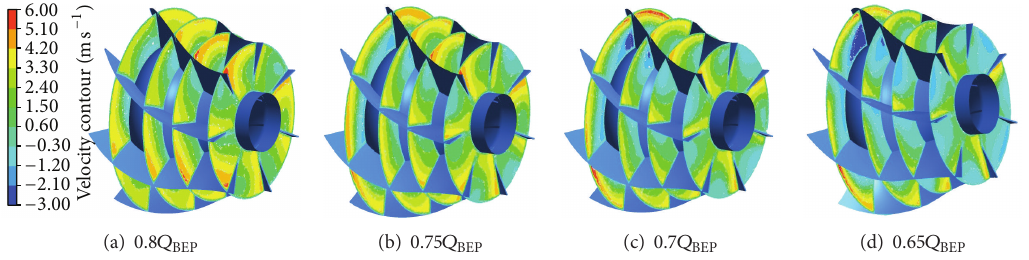
Figure 16: Axial velocity contour in the vane diffuser at partial flow rate.